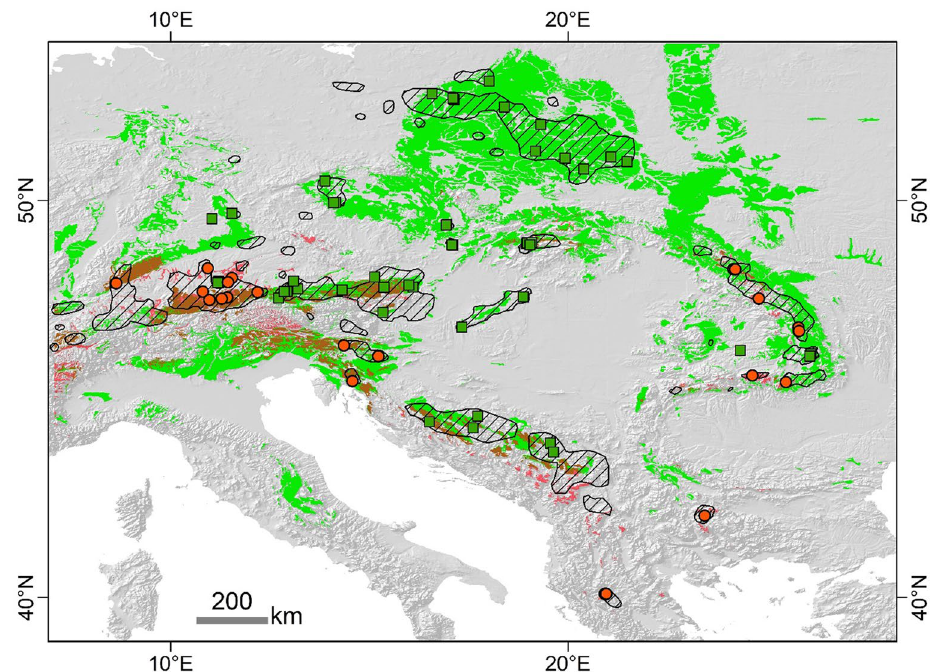
Figure 7. Potentially suitable areas for the cytotypes of F. amethystina according to the projection of the current climate conditions. Maxent models were based on climatic and parent material of soils. The colour areas (red— diploids, green—tetraploids, mixed—both cytotypes) indicates potentially suitable places above the MTSS threshold. Hatching areas—patches of the true range of F. amethystina according to Kiedrzyński et al. 30 , updated. Points (red circle—diploids, green squares—tetraploids) indicate locations of cytotypes determined in this